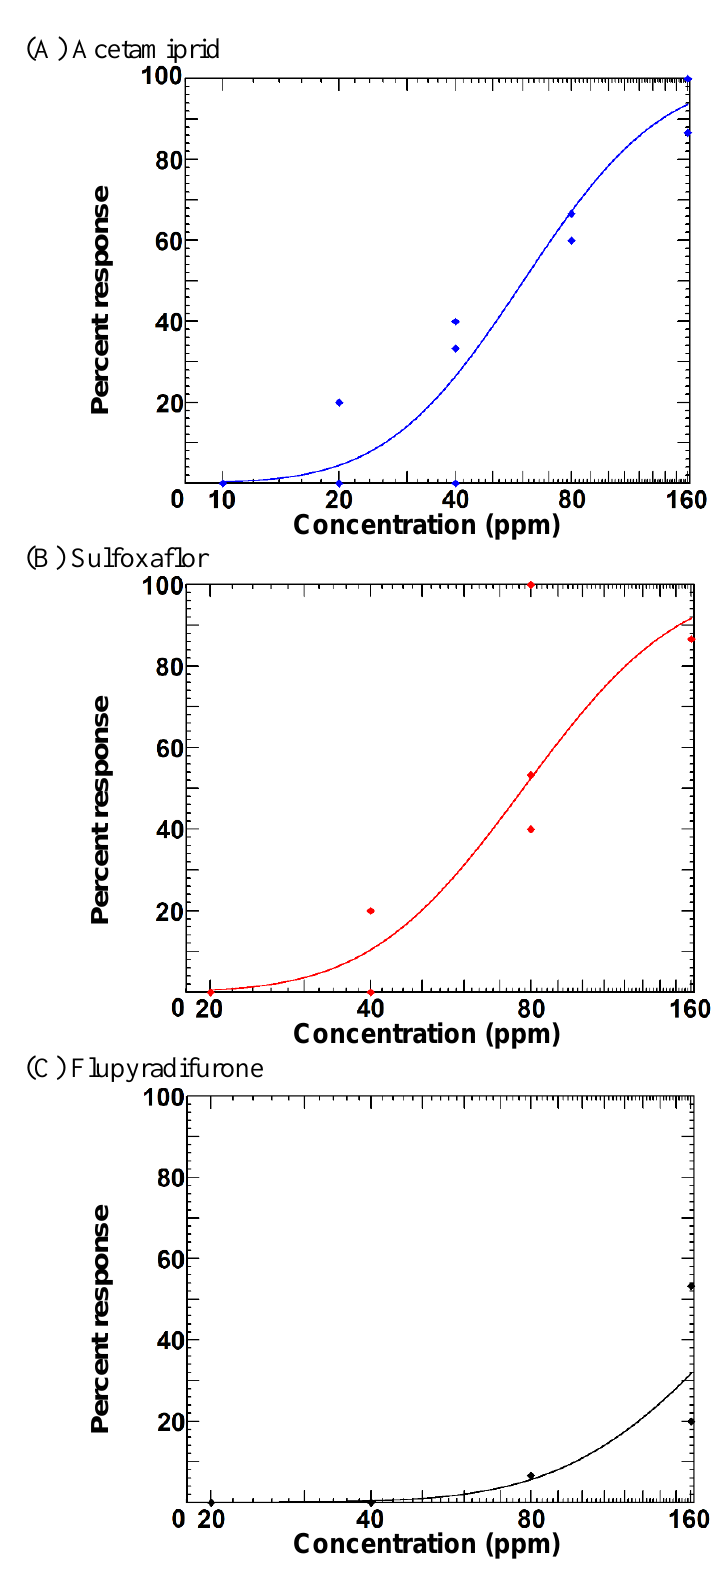
Figure 1. Toxicity responses of Apis mellifera to different systemic pesticides: acetamiprid ( A ), sul- foxaflor ( B ), and flupyradifurone ( C ) through ingestion bioassays (at 48 h after treatment). The points represent percent response; when two replications had the same percent response, the points overlapped.